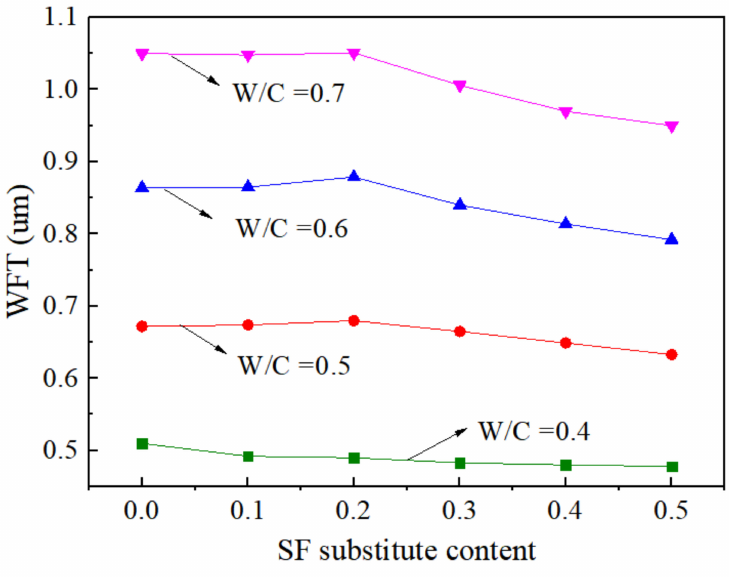
Figure 10. Variations of WFT with w/c at different SF substitute contents.